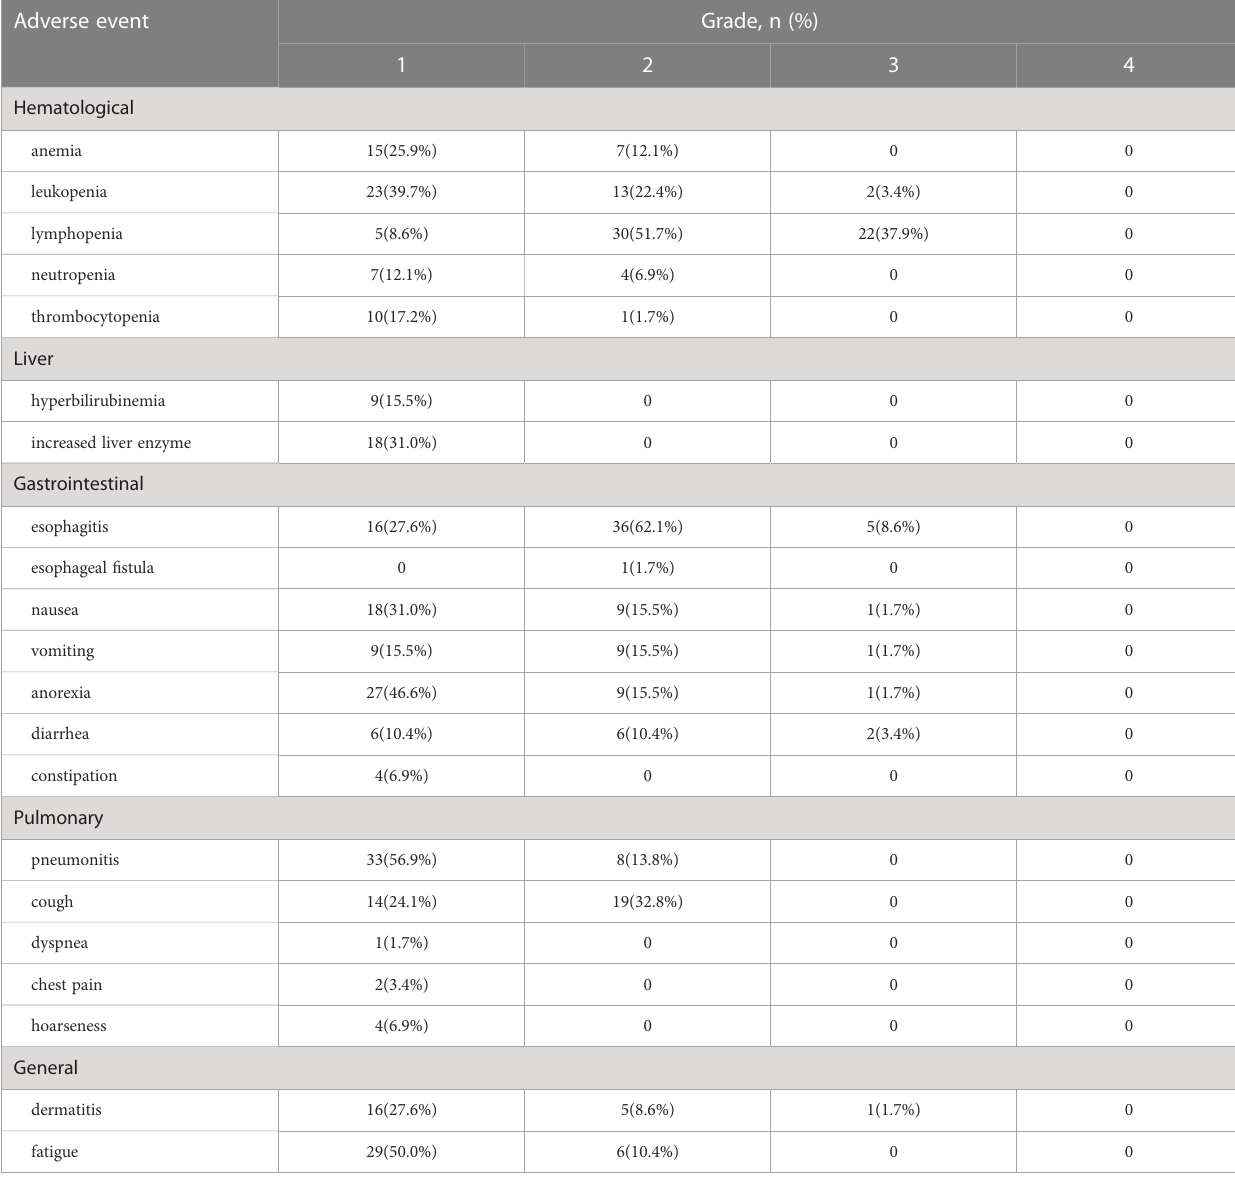
TABLE 2 Treatment-related adverse events